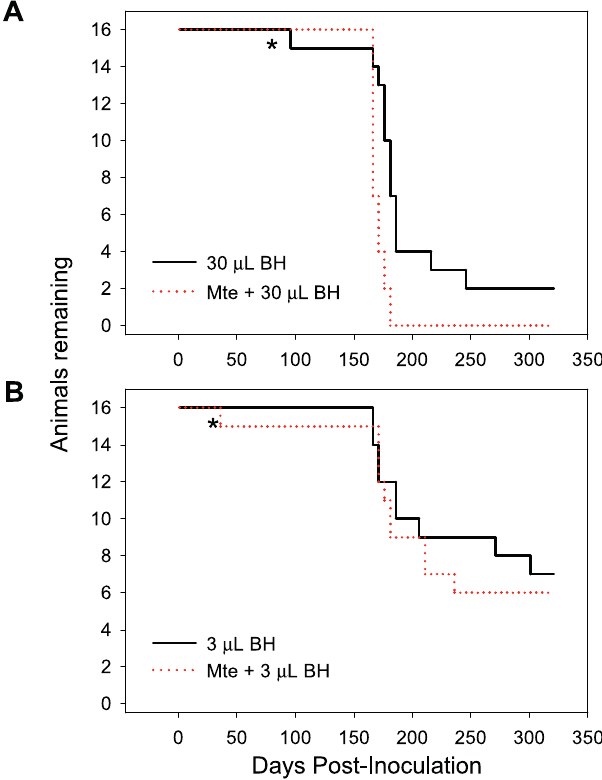
Figure 1. No Loss of Oral TSE Transmissibility Following Sorption of Prions from Infected BH to Mte (BH–Mte Mixtures) The oral transmissibility of prions in 30 (A) and 3 (B) l L was not diminished by dosing with Mte. * indicates non-TSE intercurrent death. Animals dosed with Mte alone remained healthy throughout the course of the experiment (unpublished